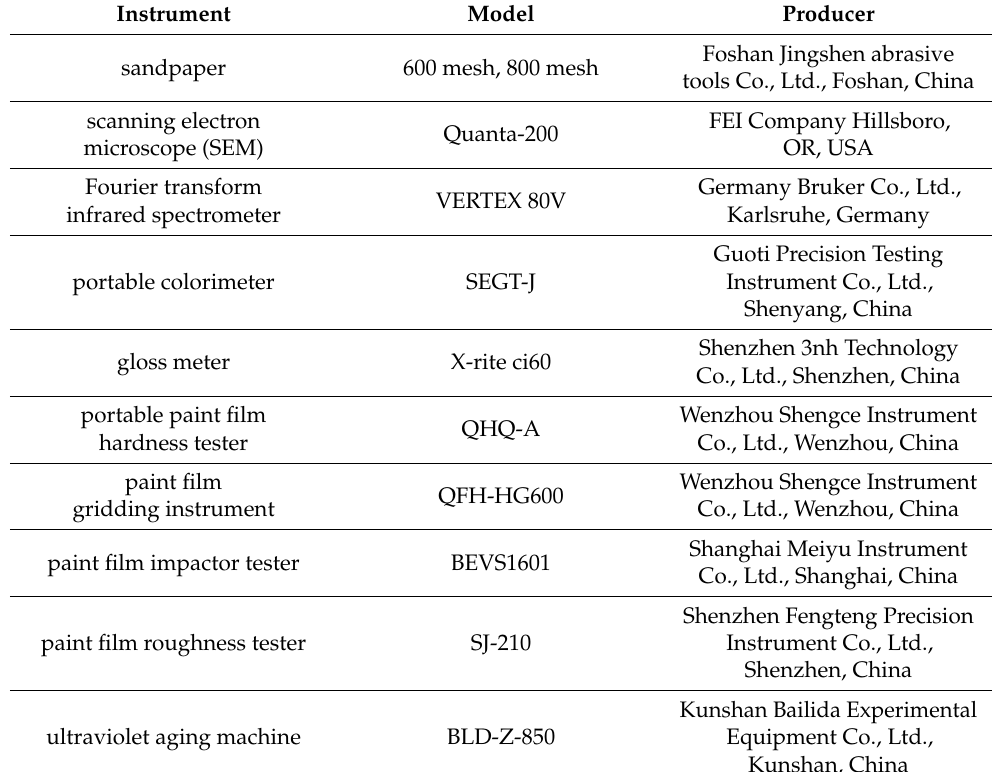
Table 5. Experimental instrument